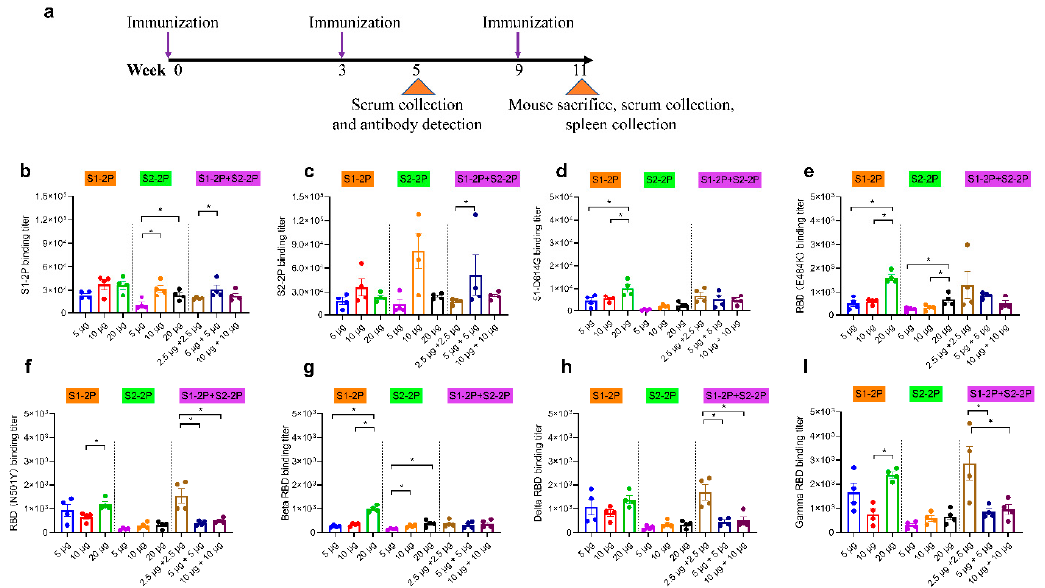
Figure 3. Cross-binding antibodies in the serum of vaccinated mice at different immunization doses. ( a ) Schematic of mouse vaccination. S1-2P-specific IgG titer ( b ), S2-2P-specific IgG titer ( c ), S1-D614G -specific IgG titer ( d ), E484K RBD-specific antibody titer ( e ), N501Y RBD-specific antibody titer ( f ), Beta RBD-specific antibody titer ( g ), Delta RBD-specific antibody titer ( h ), and Gamma RBD-specific antibody titer ( i ) of immunized BALB/c mice were determined by ELISA. The dots of different colors represented mouse serum of different immune groups. The data were represented as the reciprocal of the serum dilution that led to a half-maximal binding signal. Statistical significance was determined using one-way ANOVA or t -test and is indicated as * for p < 0.05. After the third immunization, cross-binding antibody titers to different S or RBD pro- teins increased by 1.1 to 40.6 times, and the significant increasements (>5-fold) in N501Y RBD-, Beta RBD-, and Delta RBD-binding antibody titers were detected among all the